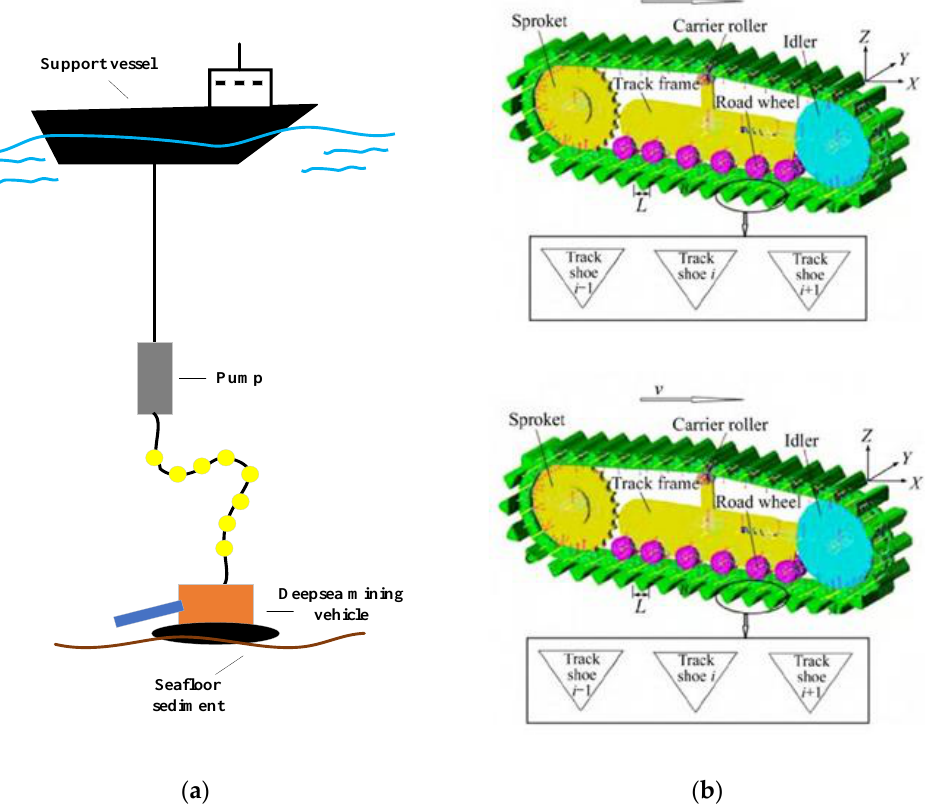
Figure 1. ( a ) Schematic diagram of the deep-sea mining system, ( b ) the arrangement of the grouser and the track Reprinted from Ref. [3].